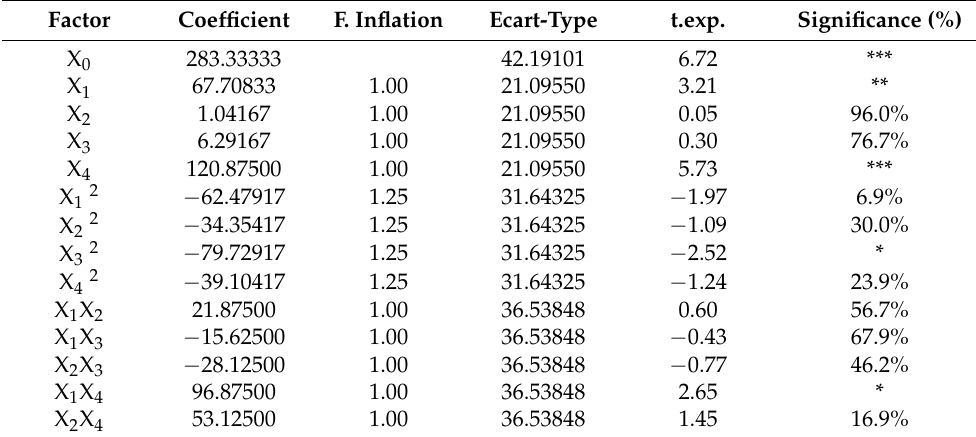
Table 9. Statistical analysis of the coefficients for PE production response.